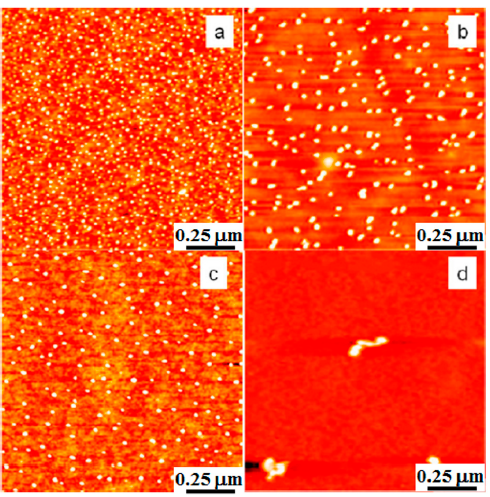
Figure 20. Atomic Force Microscopy images (1 μ m × 1 μ m) of 0.1 nm Au deposited on a single-layer graphene ( a ) and on graphite ( b ). ( c , d ) show the same samples (Au on single-layer graphene in ( c ) and Au on graphite in ( d )) after 2 h of thermal annealing at 350 °C. Reproduced from Reference [60] with permission from the American Chemical Society.